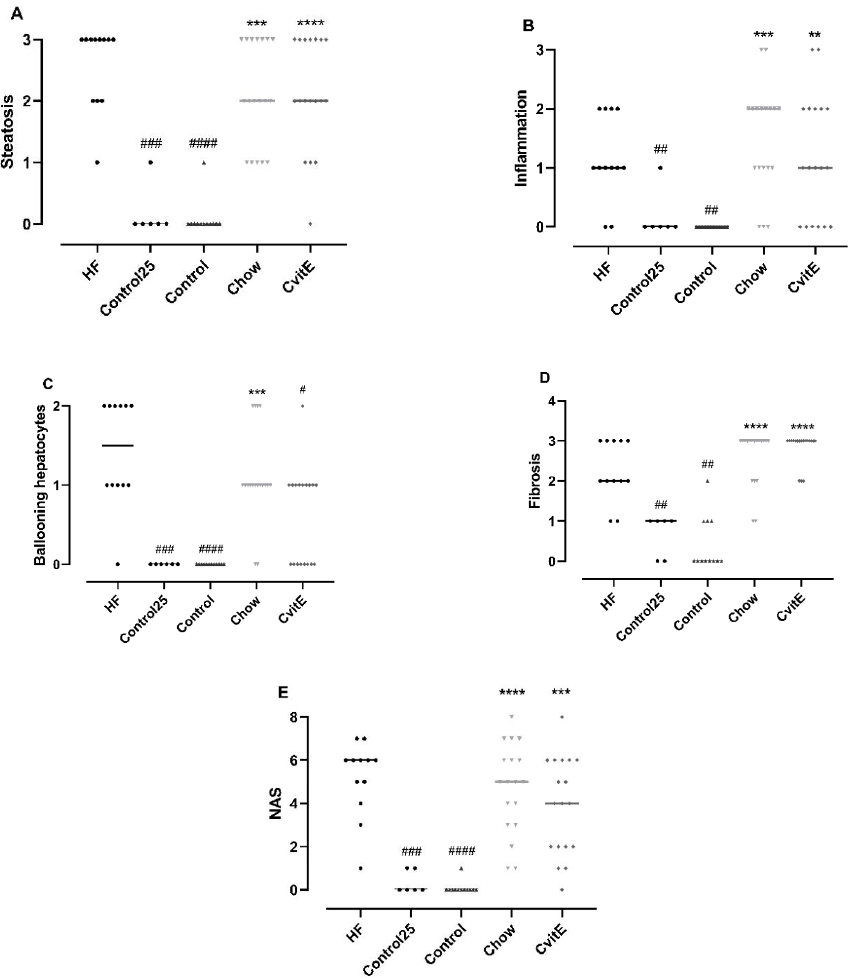
Figure 2. Histopathological evaluation of disease severity. ( A ) Steatosis: Control25 and Control animals showed significantly lower steatosis grade compared with HF. Chow and CvitE showed significantly increased steatosis compared with Control and were not di ff erent from HF. ( B ) Inflammation: Control25 and Control were significantly decreased compared with HF, while Chow and CvitE were significantly increased compared with Control with no di ff erence compared to HF. ( C ) Ballooning hepatocytes; Control25 and Control were significantly di ff erent from HF and Chow significantly di ff erent from Control. CvitE was significantly reduced compared with HF and not di ff erent from Control. ( D ) Fibrosis; Control25 and Control had a significantly lower fibrosis score compared with HF and Chow and CvitE had a significantly increased fibrosis score compared with Control with no di ff erence compared to HF. ( E ) NAFLD activity score (NAS): in the evaluation of disease severity no e ff ect of treatment was observed in Chow and CvitE, which was not di ff erent from HF and significantly increased compared with Control. Control25 and Control were significantly reduced compared with HF. Data are